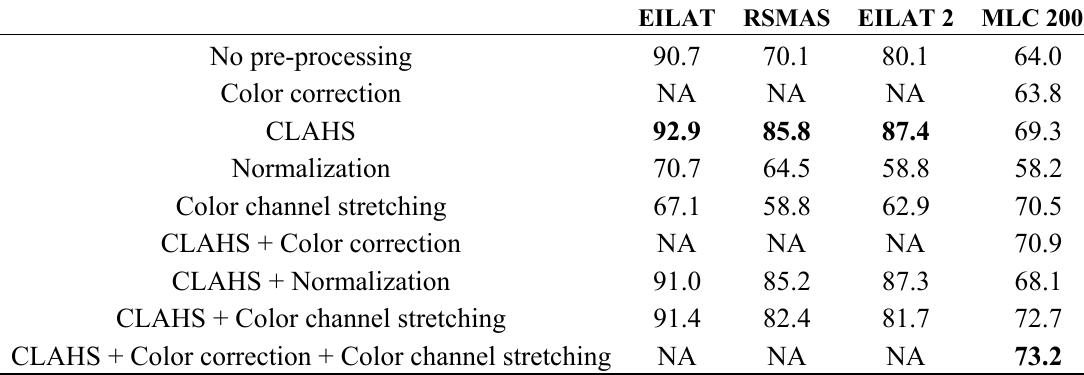
Table 4. Overall accuracy (%) with different image enhancement options as evaluated with the EILAT, RSMAS, EILAT 2 and MLC 2008 datasets. The configurations for the other steps are fixed as follows. Feature extraction: completed local binary pattern (CLBP), grey level co-occurrence matrix (GLCM), Gabor filter response, opponent angle and hue channel histogram; kernel mapping: L1 normalization; dimension reduction: